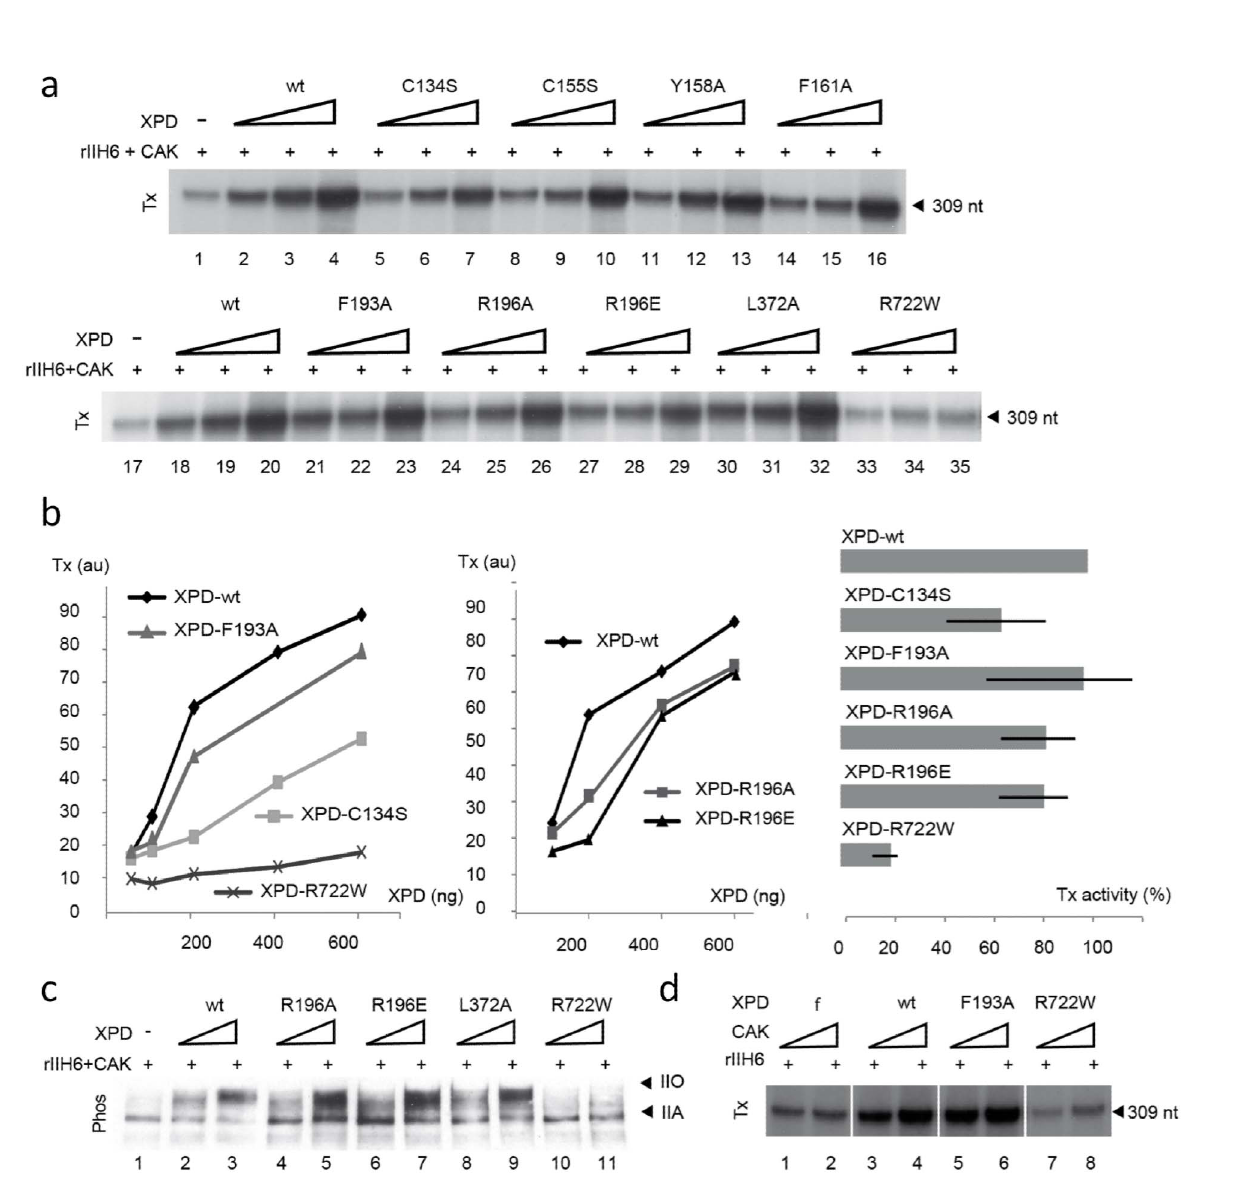
Figure 5. Transcriptional activity of hsXPD and its variants. (a) Basal transcription activity. Increasing amounts of the recombinant XPD variants ( , 50, 100, and 250 ng) were mixed with purified core-TFIIH (rIIH6) (250 ng) and CAK (300 ng) to an in vitro reconstituted transcription system containing all the basal transcription factors and the AdMLP. Transcripts were analyzed by electrophoresis followed by autoradiography. The length of the corresponding transcript is indicated on the right side. (b) Dose–response curves for XPD-wt and mutants C134S, F193A, R196A/E, and R722W. We have selected the hsF193A and hsR196A/E variants that exhibited levels of transcription similar to wild-type hsXPD as a reference. The transcription activity was estimated from densitometric analysis of autoradiograms (arbitrary units). The data are also plotted as % wild-type activity in the panel to the right. (c) CTD phosphorylation of RNAP II by reconstituted TFIIH with XPD variants was analyzed by SDS-PAGE and followed by WB detection. Purified core-TFIIH (250 ng), CAK (300 ng), and XPD variants (100 or 300 ng) were mixed in an in vitro assay containing all the basal transcription factors and the AdMLP. Arrows indicate hypophosphorylated (IIA) and hyperphosphorylated (IIO) forms of RNAP II. (d) Transcription activity of reconstituted TFIIH containing XPD variants (250 ng core-TFIIH and 200 ng XPD) was assessed in the presence of different amounts of purified recombinant CAK (150 and 300 ng).